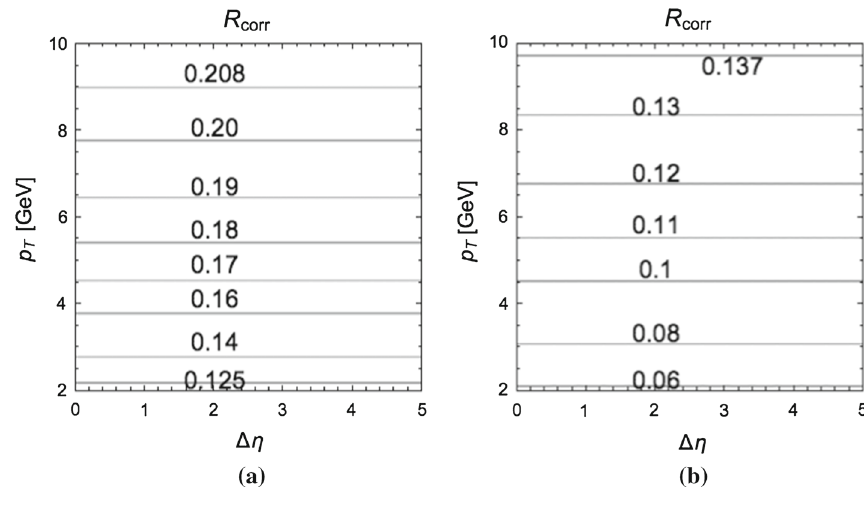
Fig. 3 Correlation factor as a function of Δη and p T for different starting points of the QCD evolution, namely = 0 . 5GeV 2 ( a ), and Q 2 0 = 1 . 0GeV 2 ( b ) Q 2 0